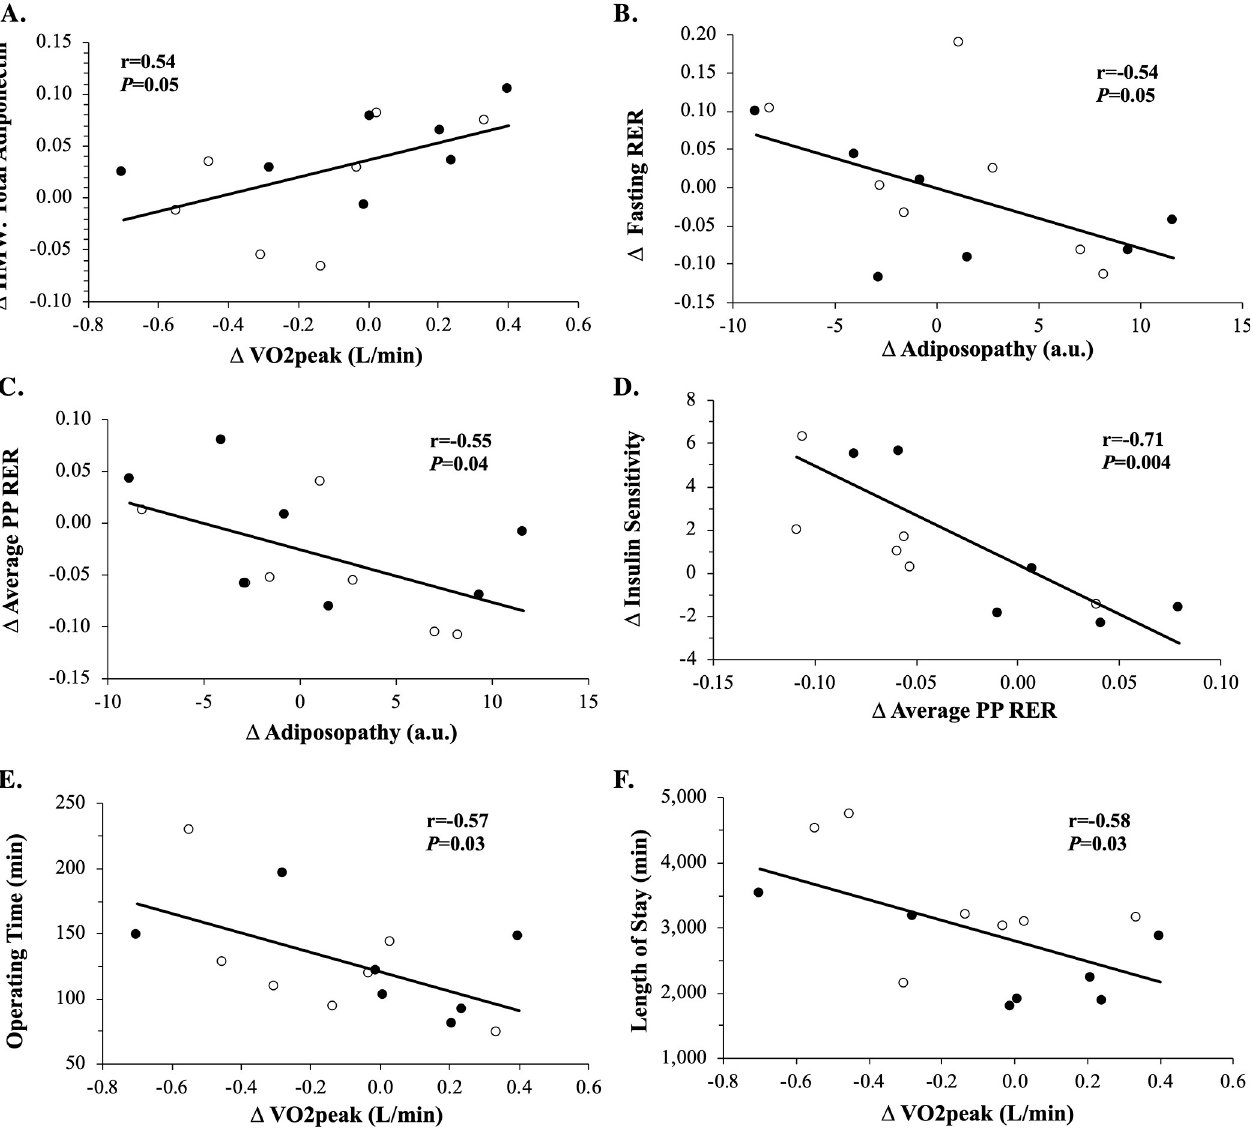
Fig 4. Correlations in metabolic outcomes following the intervention. The change ( Δ ) in VO 2 peak (L/min) to the Δ in the ratio of high molecular weight (HMW) to total adiponectin ( A ). The Δ in HMW adiponectin:leptin to the Δ in fasting respiratory exchange ratio (RER) ( B ) and Δ in average post-prandial (PP) RER ( C ). The Δ in peripheral insulin sensitivity to the Δ in PP RER ( D ). The Δ in VO 2 peak (L/min) to operating time ( E ) and length of hospital stay ( F ).